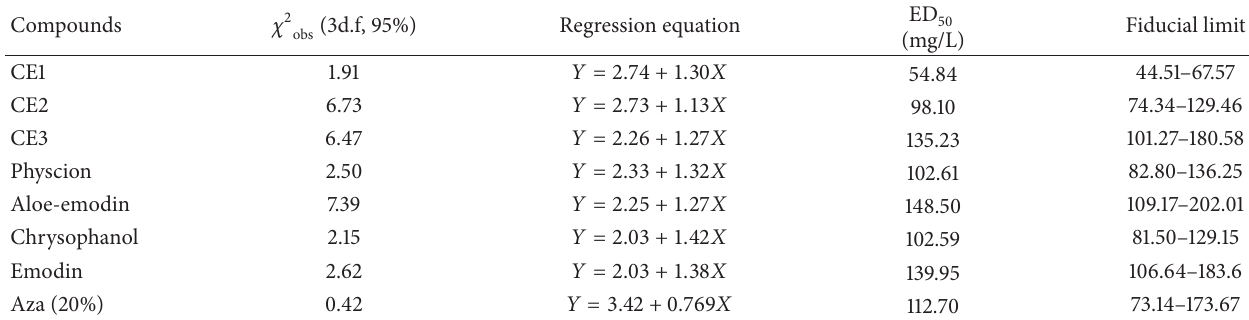
Table 2: Antinemic activity (ED after 72 hrs.